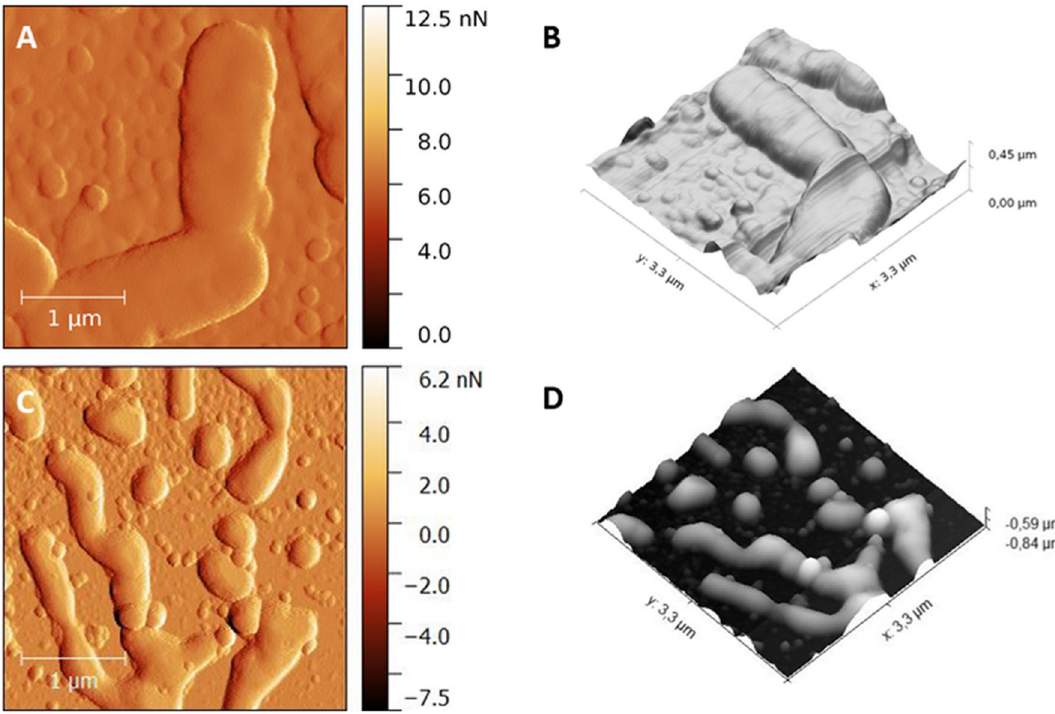
Figure 7. AFM 2D topografy (left panel) ant the corresponding 3D reconstructions (right panel) images of P.aeruginosa cells before therapy ( A , B , scan area: 3.3 µm × 3.3 µm) and after treatment by TPP-NPs with irradiated light dose of 3.24 J/cm 2 ( C , D , scan area: 3.3 µm × 3.3 µm). Images were processed by Gwydion